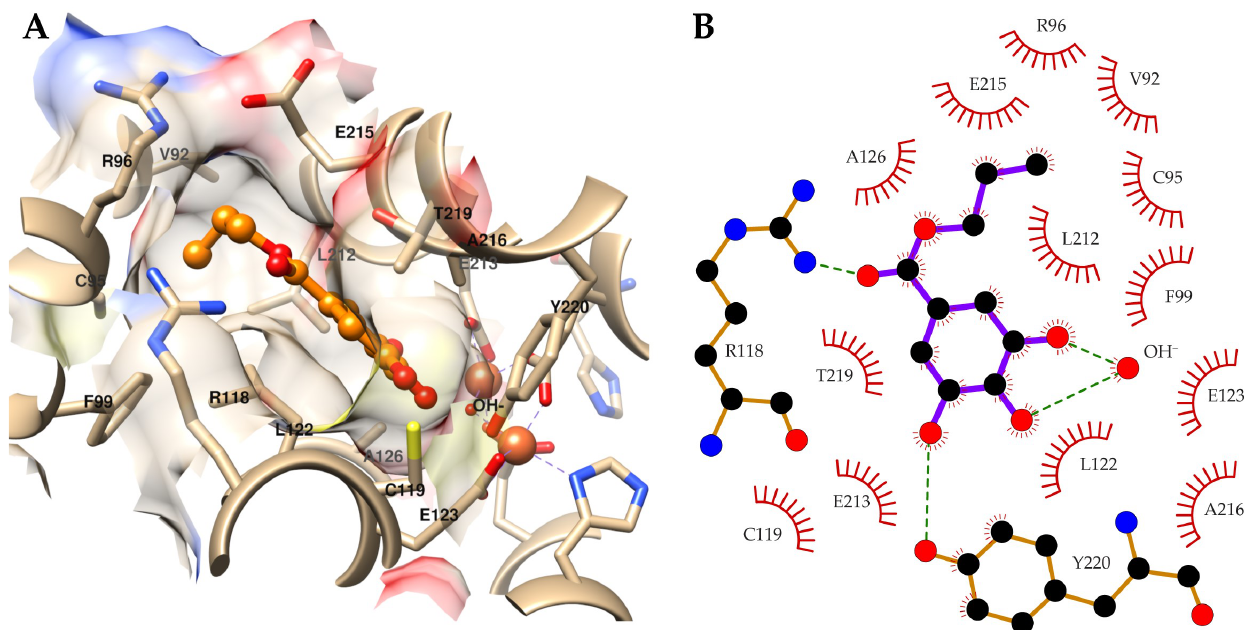
Figure 3. Predicted binding mode ( A ) and network of intermolecular interactions ( B ) of the compound 4 -TAO complex. ( A ) Compound 4 is colored orange and represented as balls and sticks. Only amino acids of TAO interacting with the compound are labeled. ( B ) Only the atoms of compound 4 and residues of TAO forming hydrogen bonds with the compound are shown. The figure was produced with UCSF Chimera and LigPlot+ [37,38].